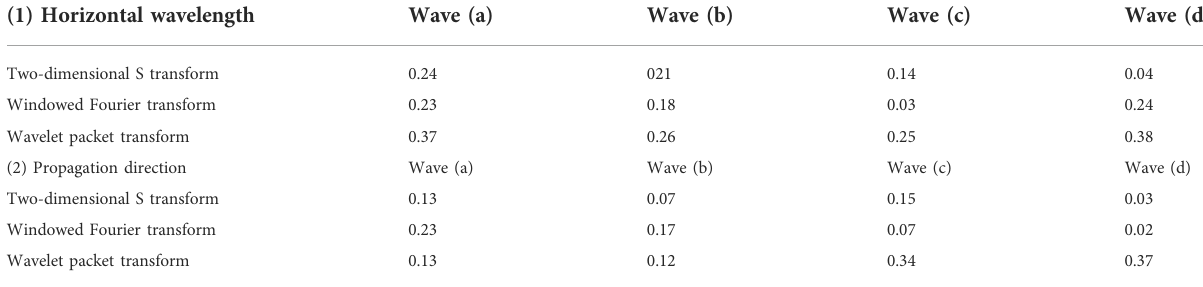
TABLE 2 Calculation errors of (a) horizontal wavelength and (b) propagation direction for the internal wave case shown in Figure 7. (1) Horizontal wavelength Wave (a) Wave (b) Wave (c) Wave (d) Two-dimensional S